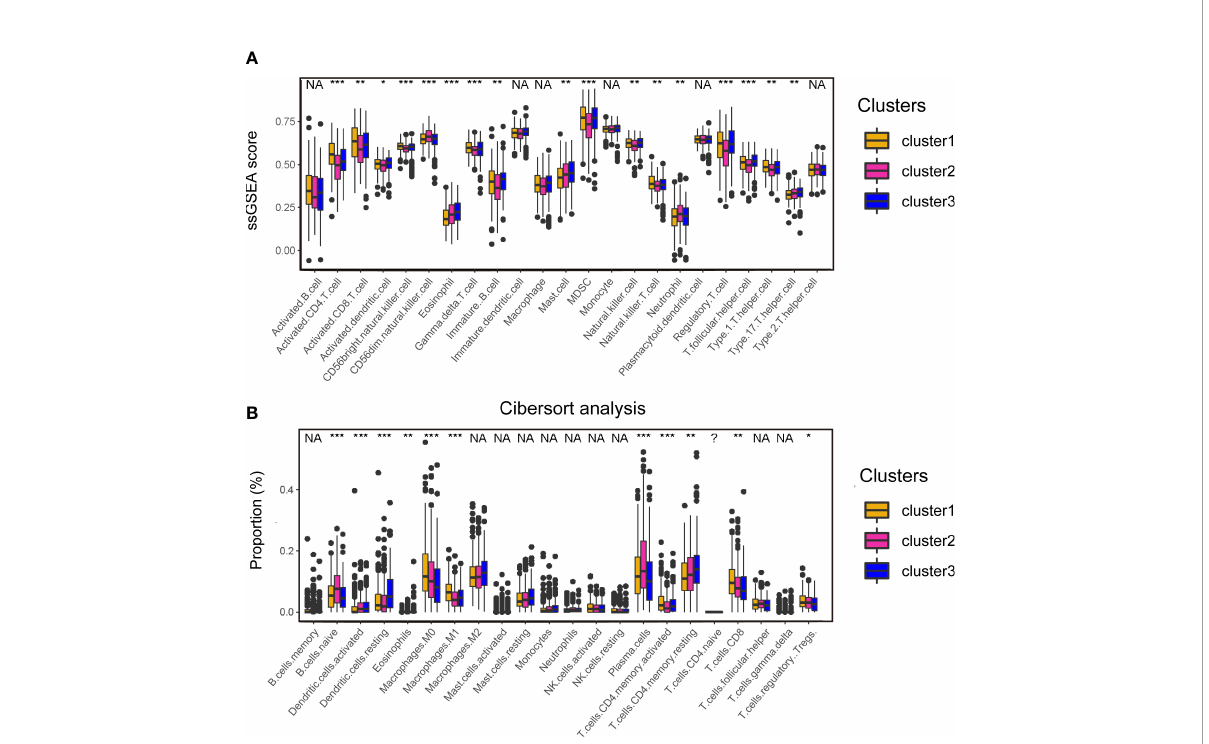
FIGURE 3 Analyses of the tumor microenvironment of cuproptosis-associated clusters. (A) ssGSEA of immune cells in three clusters. The statistical difference of three clusters was compared by the Kruskal – Wallis H test. *P < 0.05; **P < 0.01; ***P < 0.001; NA, no difference in statistics. (B) Boxplot shows the proportion of immune cells calculated by CIBERSORT analysis. The statistical difference of three clusters was compared by the Kruskal – Wallis H test. *P < 0.05; **P < 0.01; ***P < 0.001; NA, no difference in